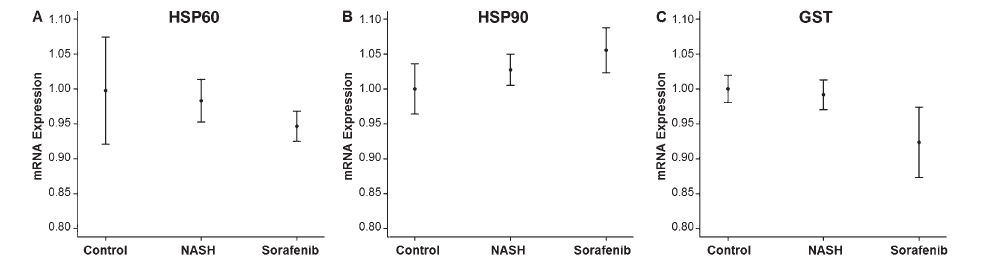
Figure 3. Graphic representation of HSP60 , HSP90 , and GST mRNA expression in control (n=4), nonalcoholic steatohepatitis (NASH; n=10), and sorafenib-treated animals (n=10). The mRNA expression of HSP60 , HSP90 , and GST did not differ among the three groups.